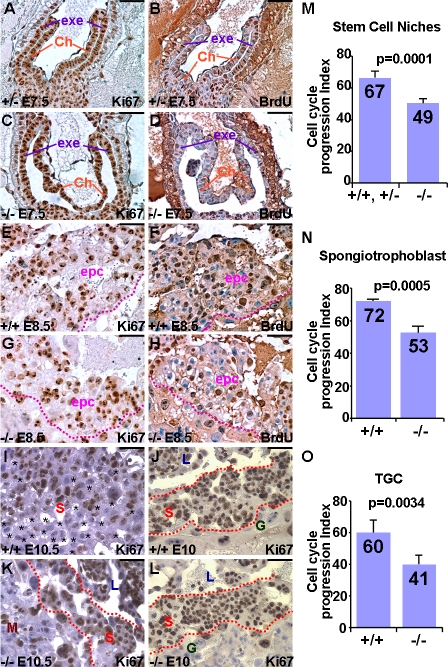
Defects in Trophoblast Cell Cycle Progression Caused by SENP2 Deficiency(A–H) In sections of the E7.5 and E8.5 SENP2+/+, SENP2+/– and SENP2–/– extraembryonic structures, Ki67 staining identified trophoblast progenitors undergoing cell cycle progression at the trophoblast stem cell niches (A,C,E,G). BrdU labeling for 1 h, performed on adjacent sections, detected the progression rate at S phase (B,D,F,H).(I–L) SENP2+/+ (I,J) and SENP2–/– (K,L) spongiotrophoblasts were analyzed by immunostaining of Ki67 at E10.5 (I,K) and E10 (J,L). Asterisks indicated the Ki67-negative cells in the SENP2+/+ spongiotrophoblast layer (I). The adjacent section of E10 placentas were stained with anti-BrdU to obtain the progression rate.(M) The graph represents cell cycle progression index, which is the average progression rate among actively cycling cells (% of BrdU divided by % of Ki67 × 102), at all stem cell niches, extraembryonic ectoderm, chorion and ectoplacental cone (p = 0.0001, n = 6). The positive and negative cells were counted to obtain the percentages of BrdU- and Ki67-positive cells.(N,O) The graphs represent the cell cycle progression index of the spongiotrophoblast (N; p = 0.0005, n = 3) and TGC (O; p = 0.0034, n = 4) layers.Ch, chorion; epc, ectoplacental cone; exe, extraembryonic ectoderm; G, TGC; M, maternal decidua; L, labyrinth; S, spongiotrophoblast. Scale bars, 50 μm (A–L).